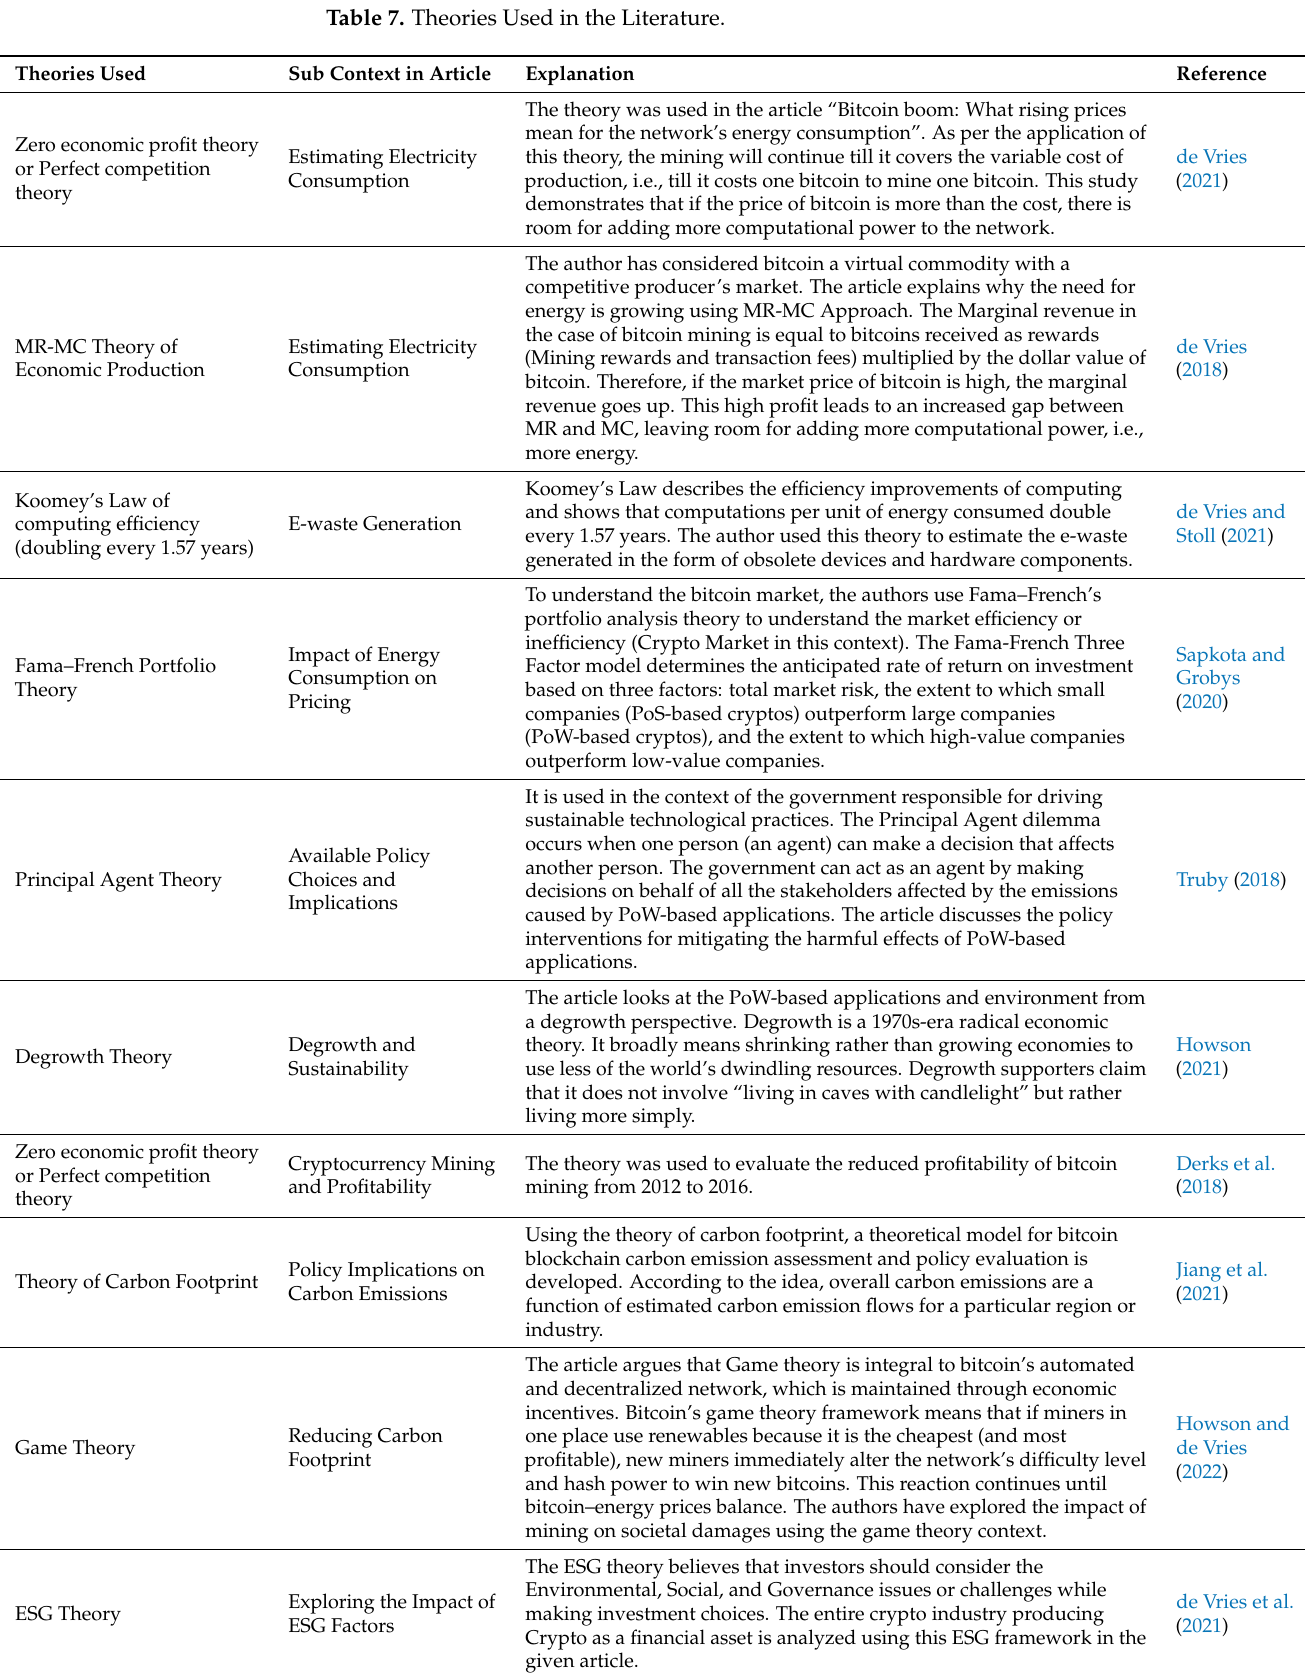
Table 7. Theories Used in the